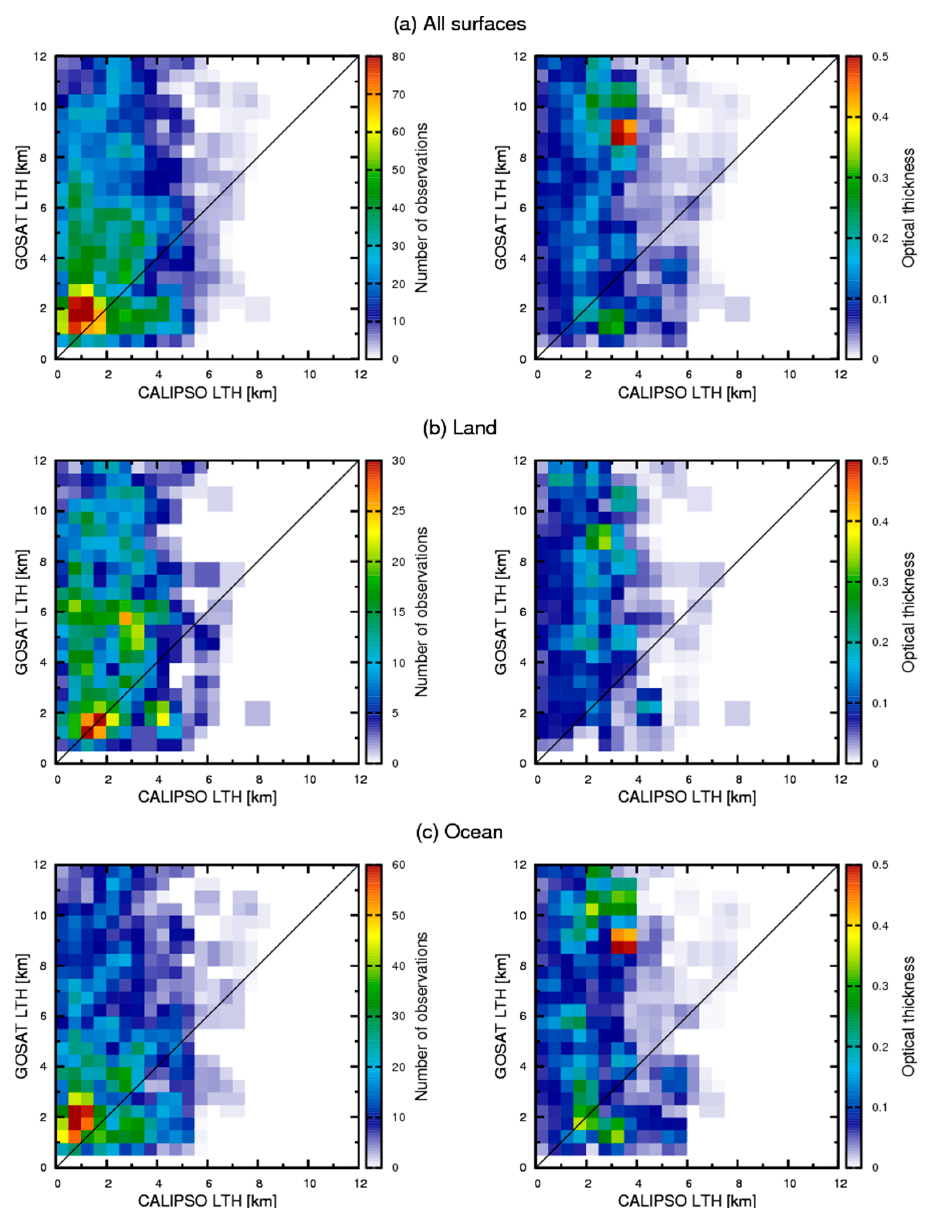
Figure 3. Left panels show the number density map of detected LTH between the slicing method and CALIPSO over ( a ) all, ( b ) land, and ( c ) ocean surfaces. Right panels show the averaged optical thickness of the aerosol layer from CALIPSO for each grid.